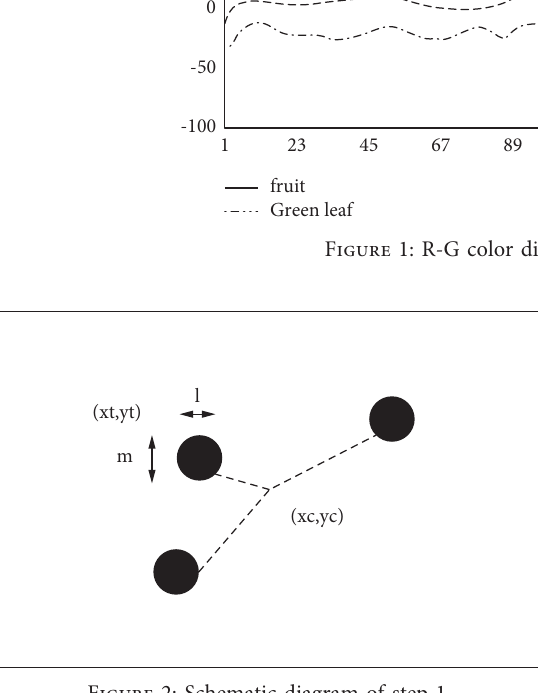
Figure 2: Schematic diagram of step 1.